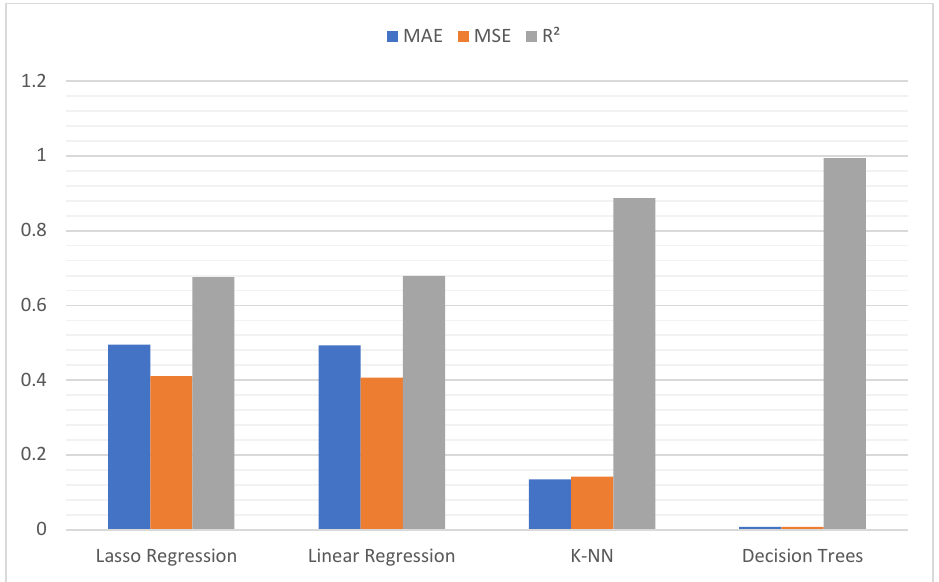
Figure 7. Data analysis results of trained models.